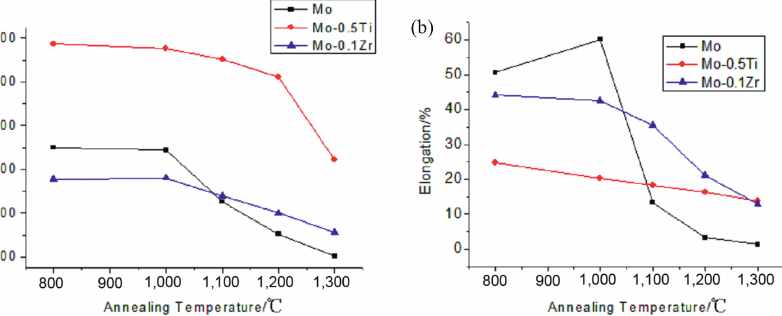
Figure 6: Tensile strength and the elongation of molybdenum, Mo-0.5Ti and Mo-0.1Zr after different temperatures of